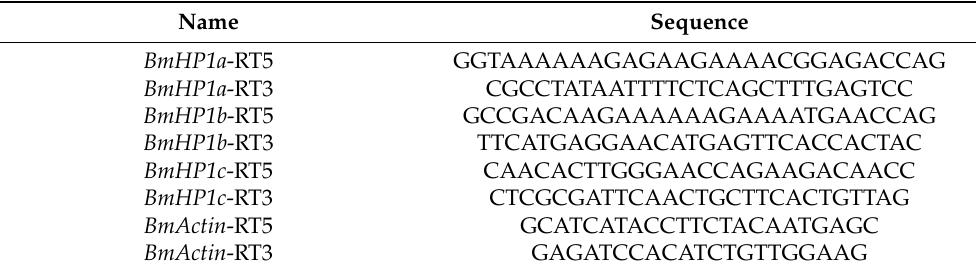
Table 1. Gene-specific primers used for semi-quantitative